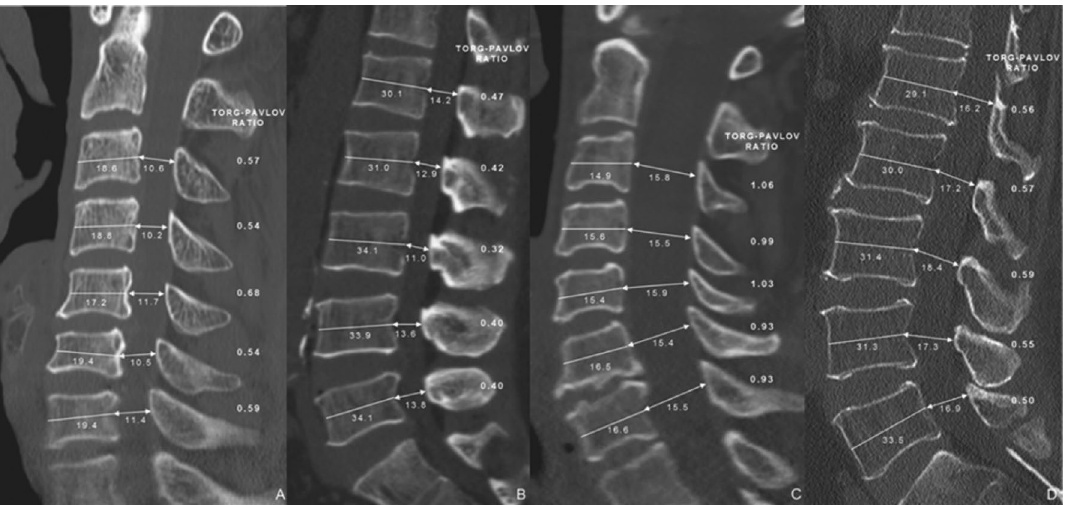
Figure 1. Representative images of two cases. ( A , B ) A 51-year-old male patient shows concurrent cervical and lumbar spinal canal stenosis. Mean spinal canal to vertebral body ratios were 0.58 (cervical) and 0.40 (lumbar). ( C , D ) Another 59 year-old female patient represents large canal diameter and high canal to body ratio (0.99: cervical and 0.55: